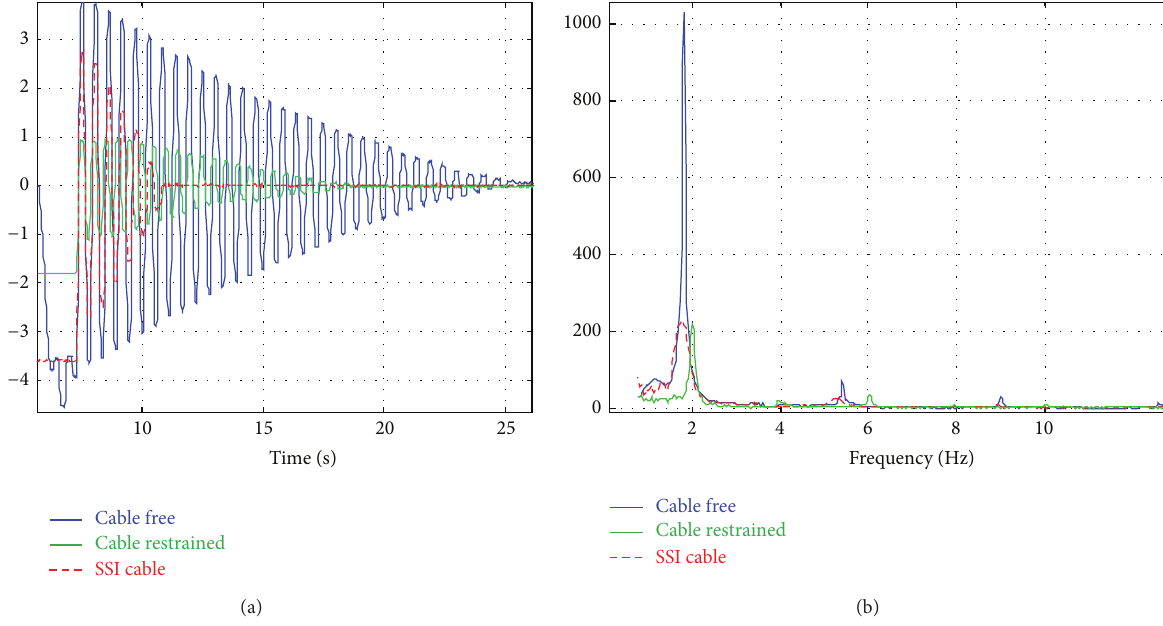
automatic modal extraction implemented for the fast impact hammer testing method (FIHT) described in [23] under MATLAB. The positive effect of the SSI is substantial even if it refers to the less favorable case since the difference between the restrained and SSI responses of cable no. 2 is the least one and the switch position is not optimized for this